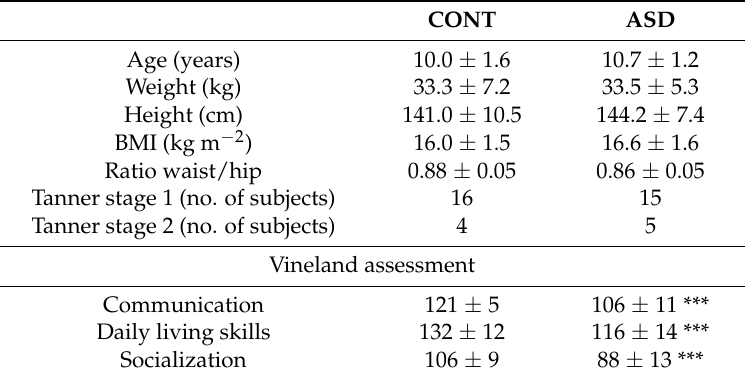
Table 1. Participants’ anthropometric characteristics and Vineland